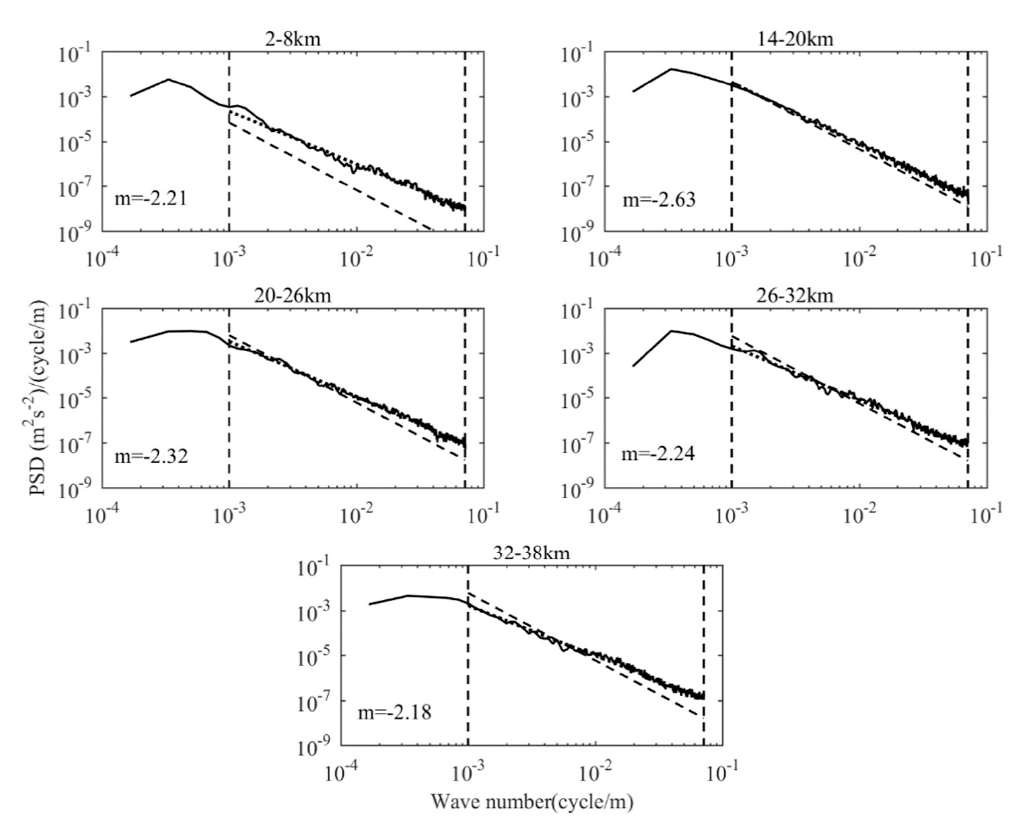
Figure 4. Mean vertical wavenumbers spectrum of normalized temperature fluctuation observed at intervals of 2–8 km, 14–20 km, 20–26 km, 26–32 km and 32–38 km. The dash line represents the saturated spectrum amplitude predicted by Equation (8), the dotted line represents the spectrum amplitude of the best linear fit, and the corresponding slope m is marked on the graph.